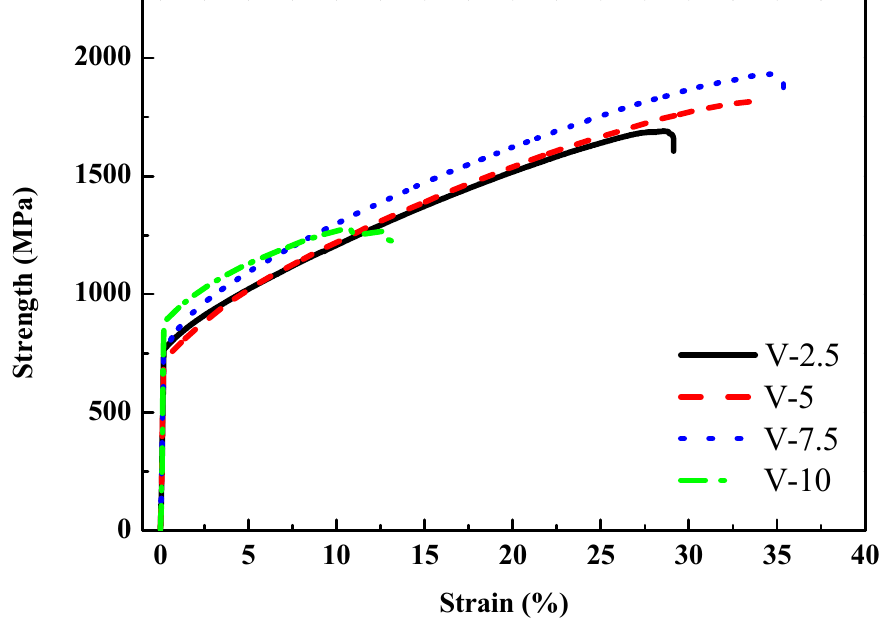
Figure 10. Mechanical compressive stress–strain curves of the Al 50 Ti 20 Cr 10 Mn 20-x V x (x = 2.5, 5, 7.5, 10) alloys.